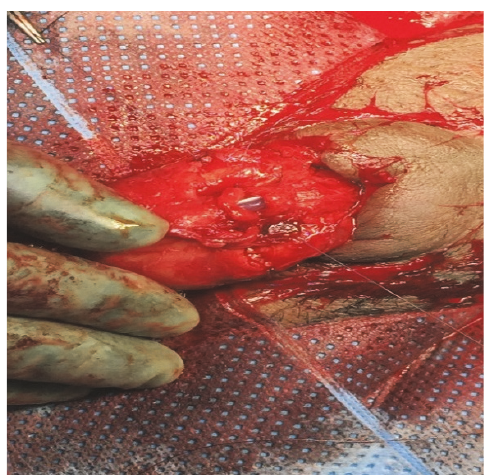
Figure 4: End to end urethral anastomosis over urethral catheter.